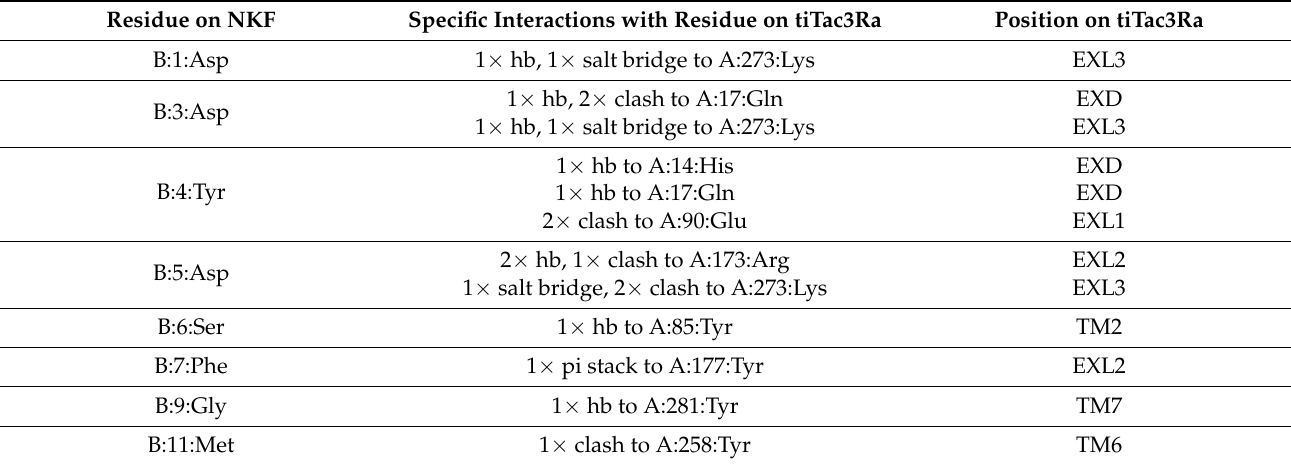
Table 3. IFD: Major Specific Binding interactions between tiTac3Ra and tiNKF (Refer Figure 2). Residue on NKF Specific Interactions with Residue on tiTac3Ra Position on tiTac3Ra